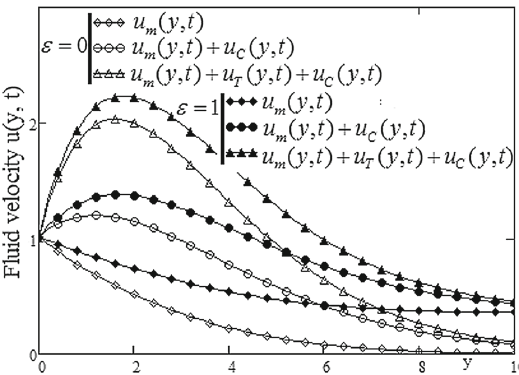
Fig. 6 Profiles of the dimensionless velocities u m , u m + u C and u m + u T + u C for Pr = 0 . 71, M = 0 . 25, Sc = 0 . 2, R = 0 . 7, Gr = 1 . 25, Gm = 0 . 5, Q = 0 . 6 and different values of time t In Fig. 6, we have plotted velocities u m ( y , t ) , u m ( y , t ) + u C ( y , t ) and u m ( y , t ) + u C ( y , t ) + u T ( y , t ) versus y to investigate the contributions of mechanical, thermal, and concentration components of velocity on the fluid motion. It is observed that contributions of mechanical, thermal, and concentration components of velocity on the fluid motion are significant and they cannot be